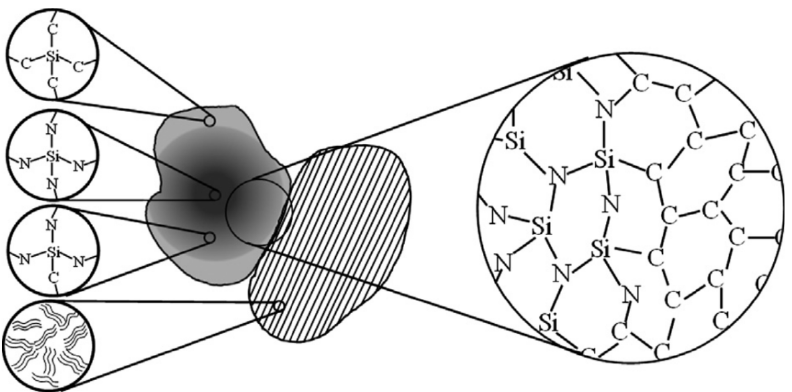
Fig. 5 Proposed nanodomain structural models for SiCN ceramics derived from polysilazane. The dark area is Si-containing phase, and the stripe area is free carbon phase. The atomic structures within these nanodomains are shown schematically in the insets. Reproduced with permission from Ref. [261], © Acta Materialia Inc.